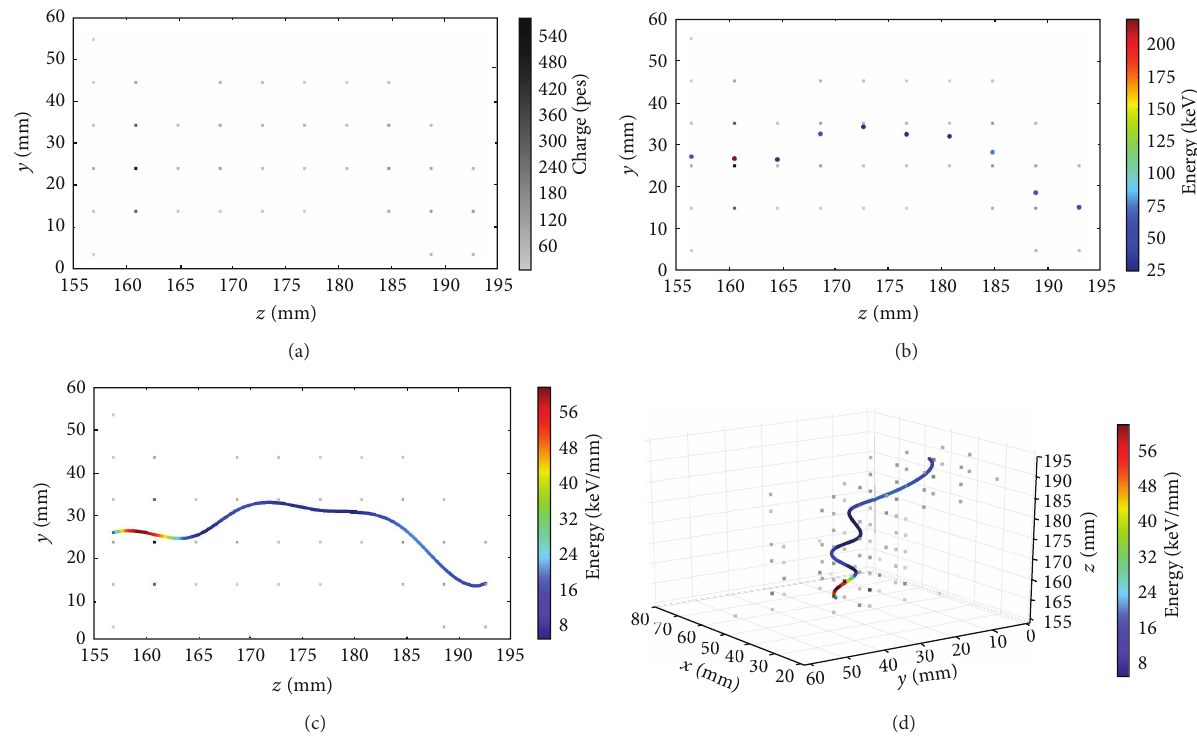
Figure 28: Example of the reconstruction of a 137 Cs track. The charge of the different SiPMs is split into slices of 4mm in width in 𝑧 (a). One point is calculated for each slice using the barycentre method and the energy of the points is then associated with the measurement made in the cathode (b). A cubic spline is used to interconnect the different points. The result is shown in the bottom line: 𝑌𝑍 projection (c) and 3D image (d) of the reconstructed track [41], where the 𝑧 coordinate is the axis of the cylindrical TPC and 𝑥𝑦 define the orthogonal